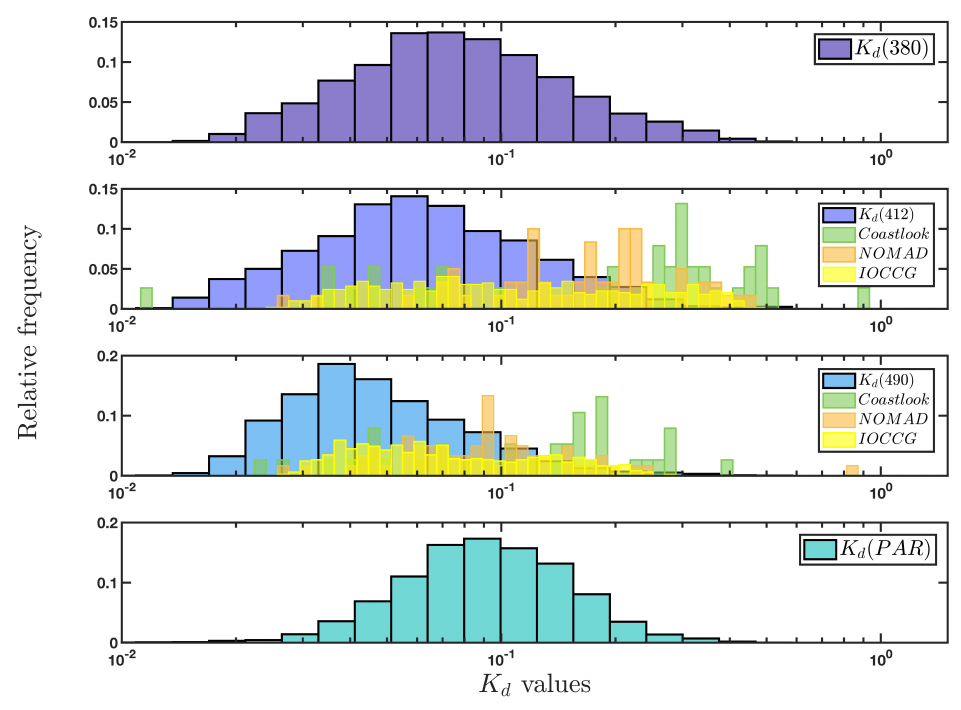
( λ ) values for the BGC-argo floats. The d ( λ ) within a specific value bin d ( 490 ) > 0.85) present R rs ( 555 )